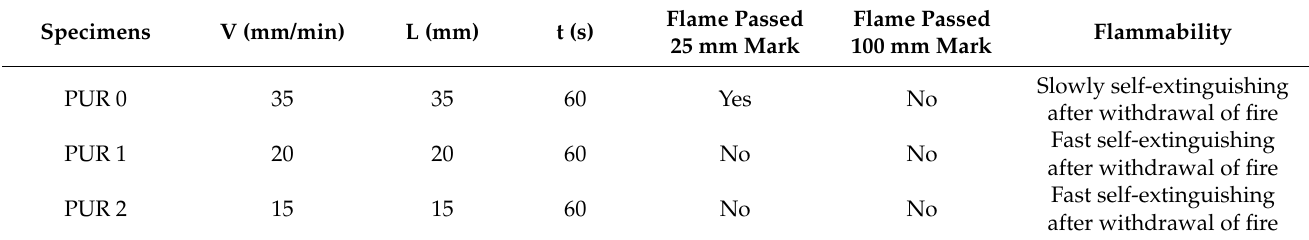
Table 4. Burnt PURs samples in accordance with UL94 standard.